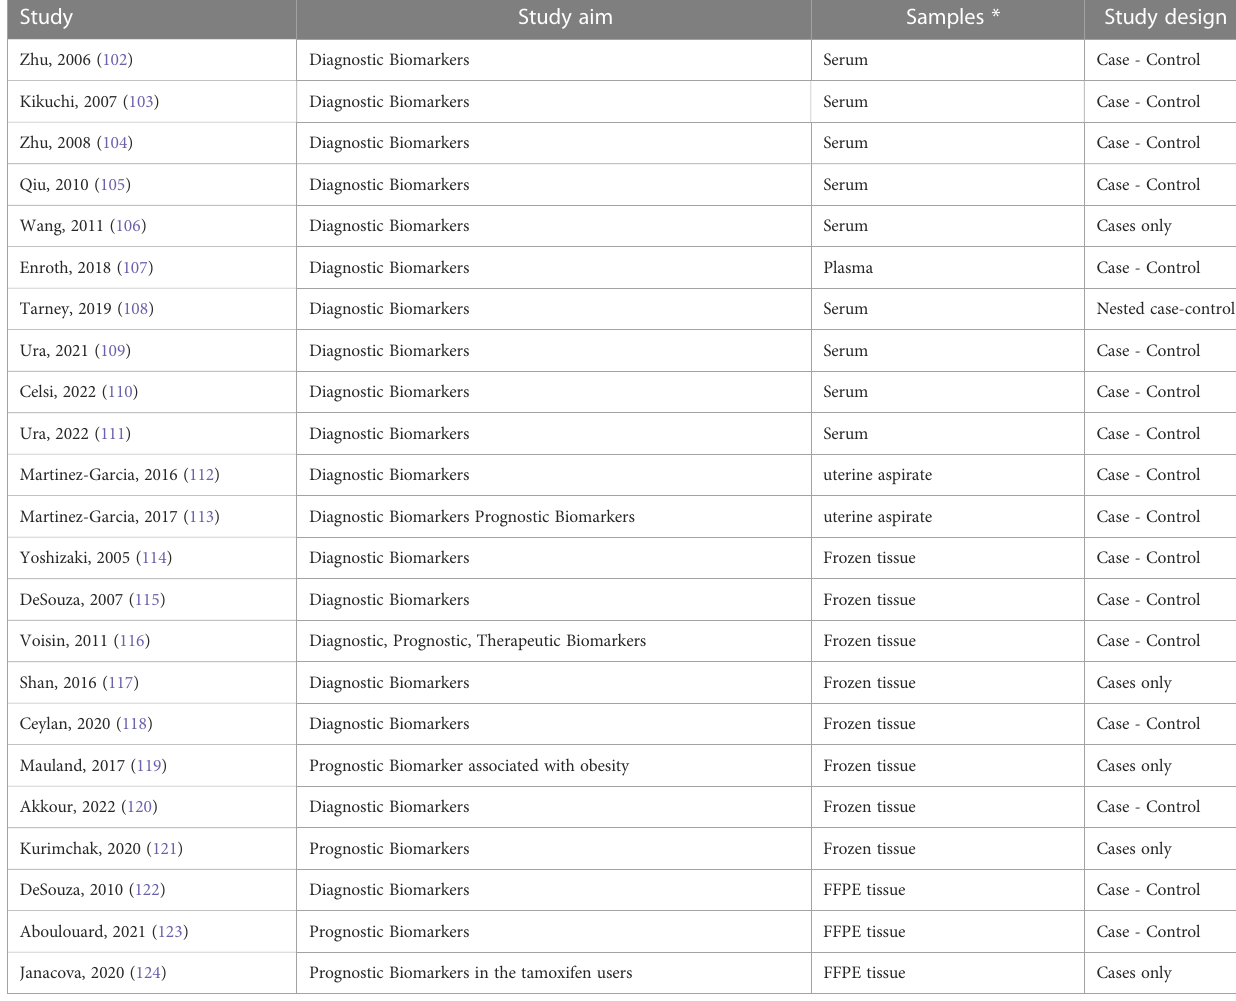
TABLE 3 List of the 23 proteomic studies in endometrial